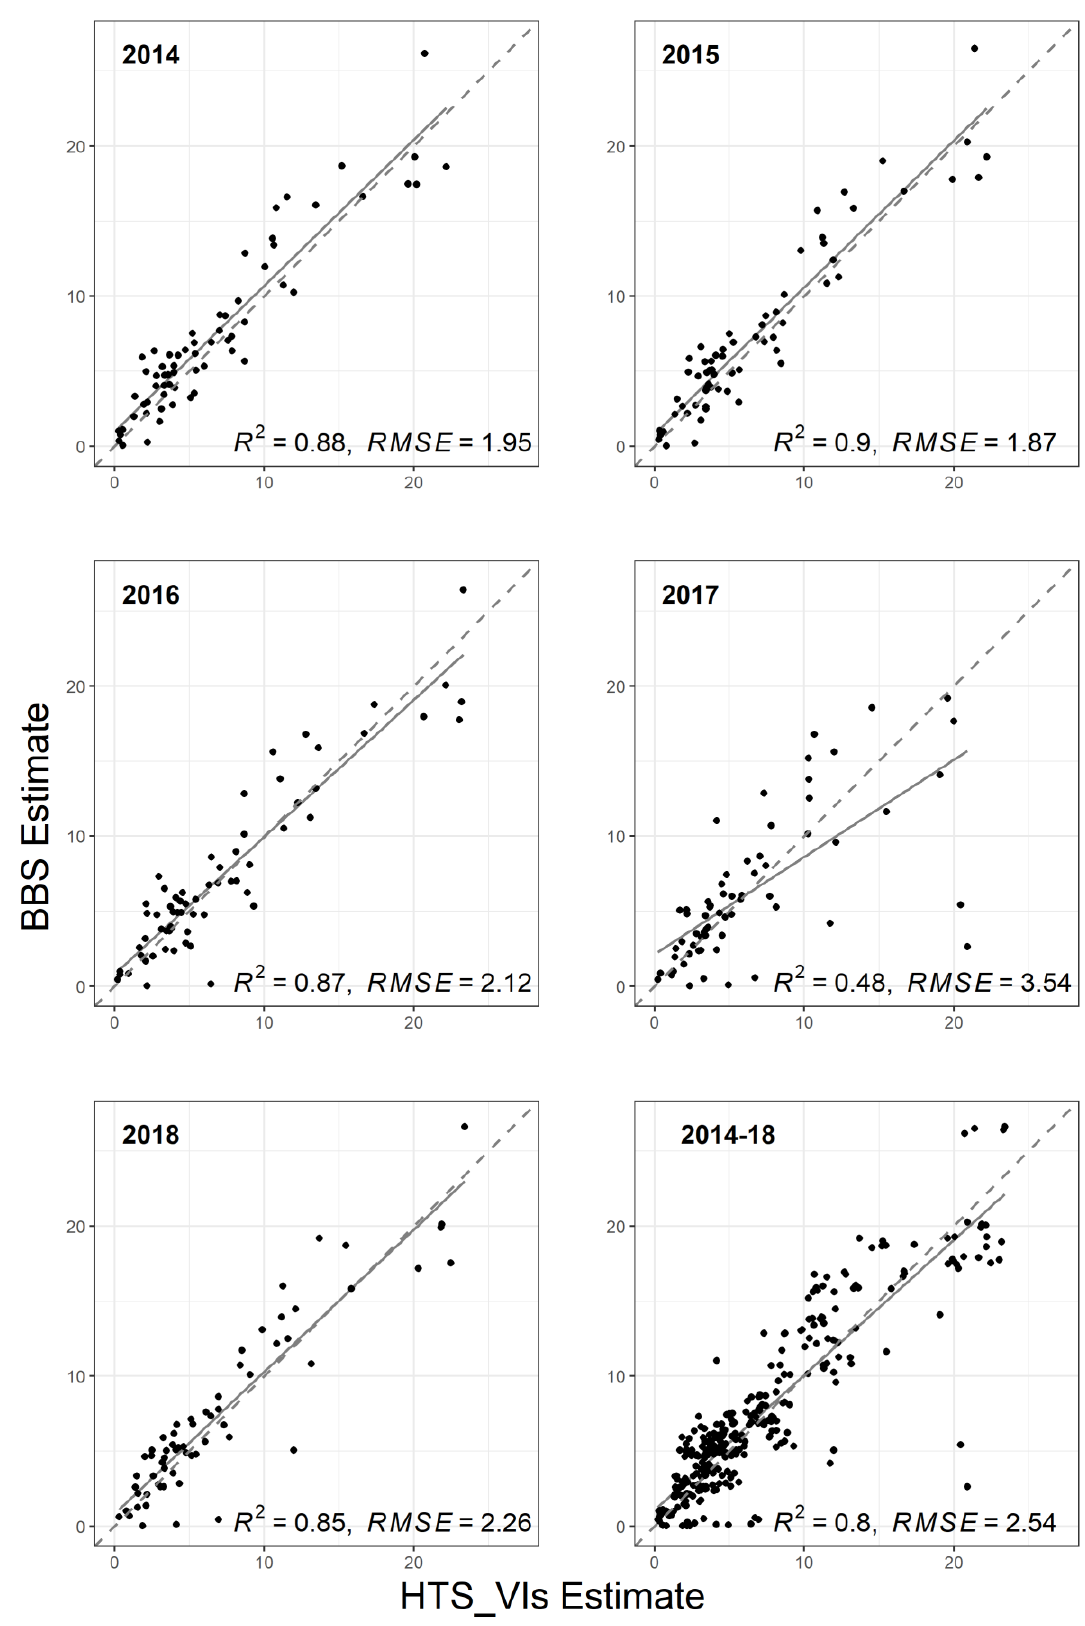
Figure 8. Comparison of district rice area (10,000 hectares) estimates for Bangladesh Bureau of Statistics (BBS) and HTS-VIs.